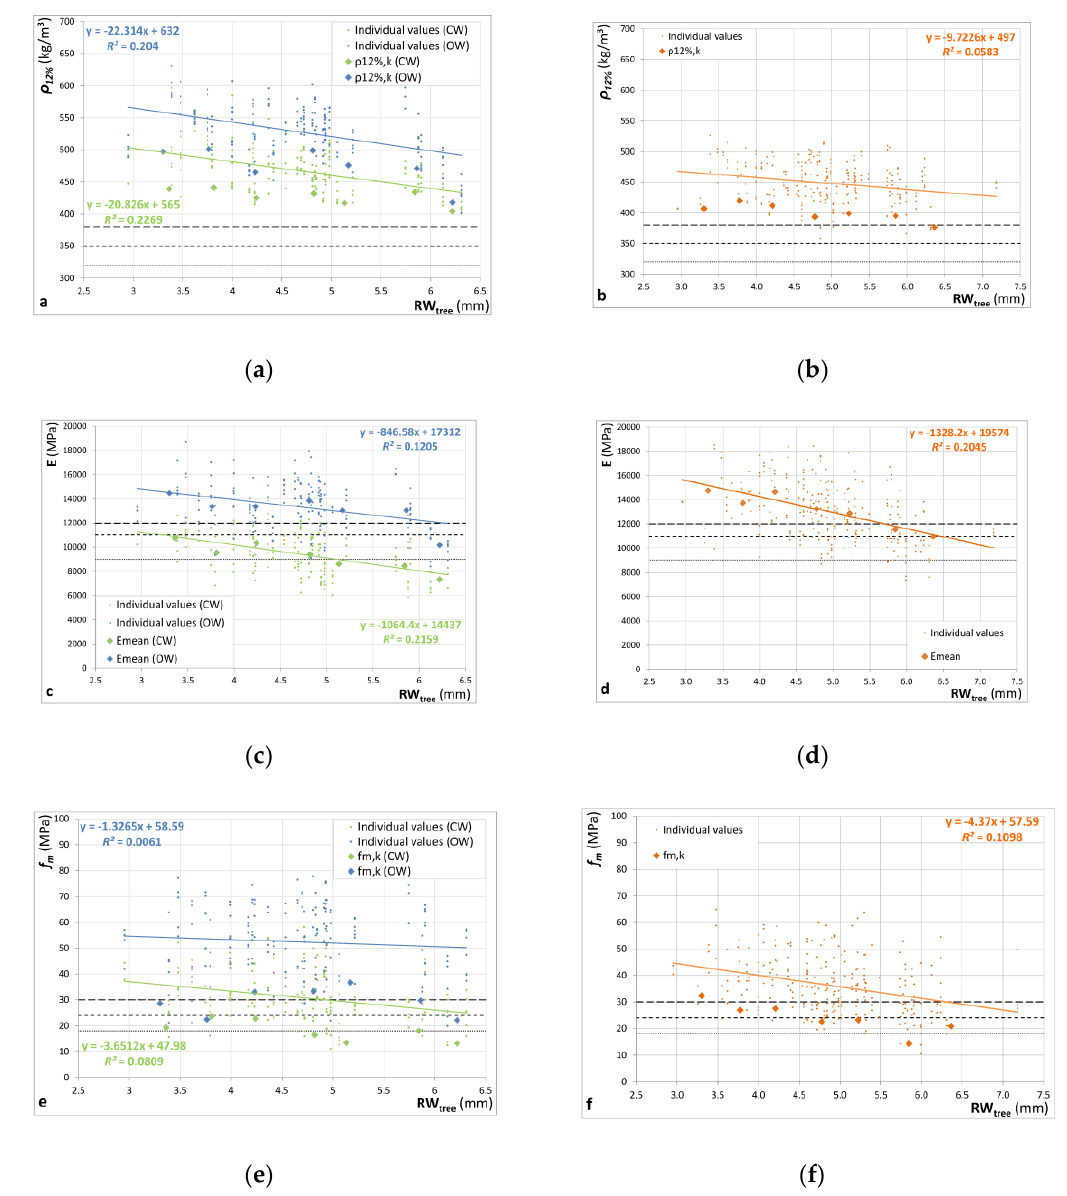
Figure 2. Density ( ρ : a and b), modulus of elasticity (E: c and d), and static bending strength ( f m : e and f) at 12% moisture content of the 445 38 × 100 mm 2 ( left ) and 261 70 × 180 mm 2 ( right ) boards, depending on the growth rate of the trees (RW tree ) from which the boards originated. The seven RW tree classes (namely: <3.5 mm; [3.5–4 mm]; [4–4.5 mm]; [4.5–5 mm]; [5–5.5 mm]; [5.5–6 mm] and ≥ 6 mm) were defined so that each of them contained at least 10 boards. For each property, the dotted lines represent the characteristic values required to comply with (from bottom to the top) strength classes C18, C24 and C30. CW: corewood; OW: